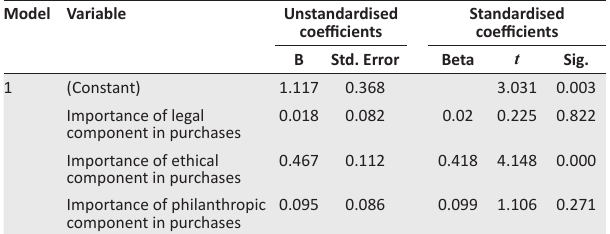
TABLE 5: Coefficients of multiple regression.